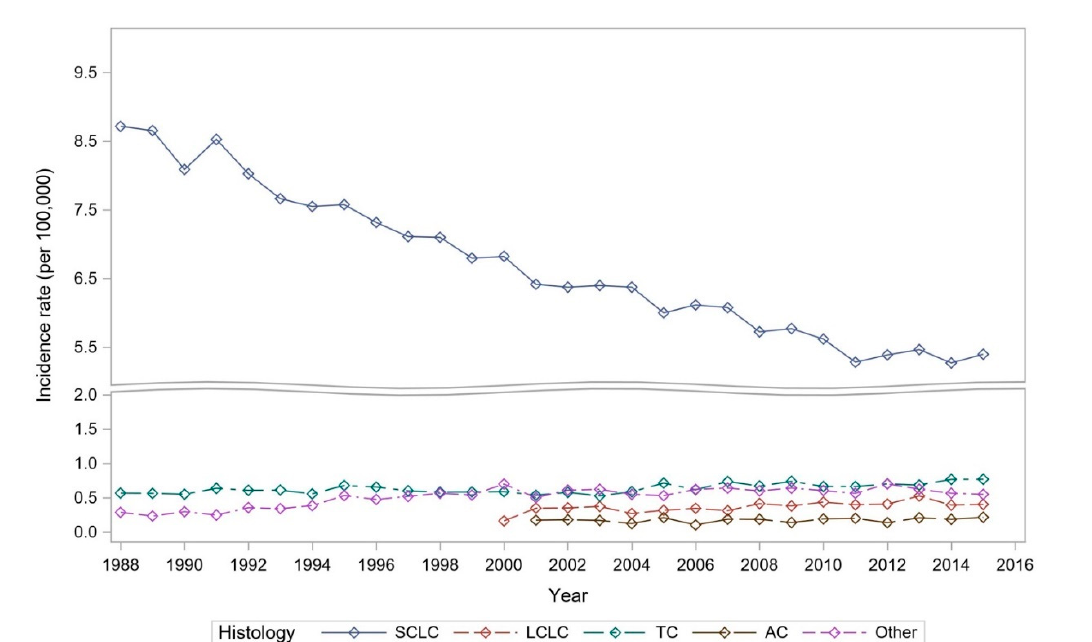
Figure 1. Incidence trends over the years among lung cancer patients with different histology (small cell lung cancer (SCLC) vs. typical carcinoid (TC), atypical carcinoid (AC), large-cell neuroendocrine carcinoma (LCNEC) and others).